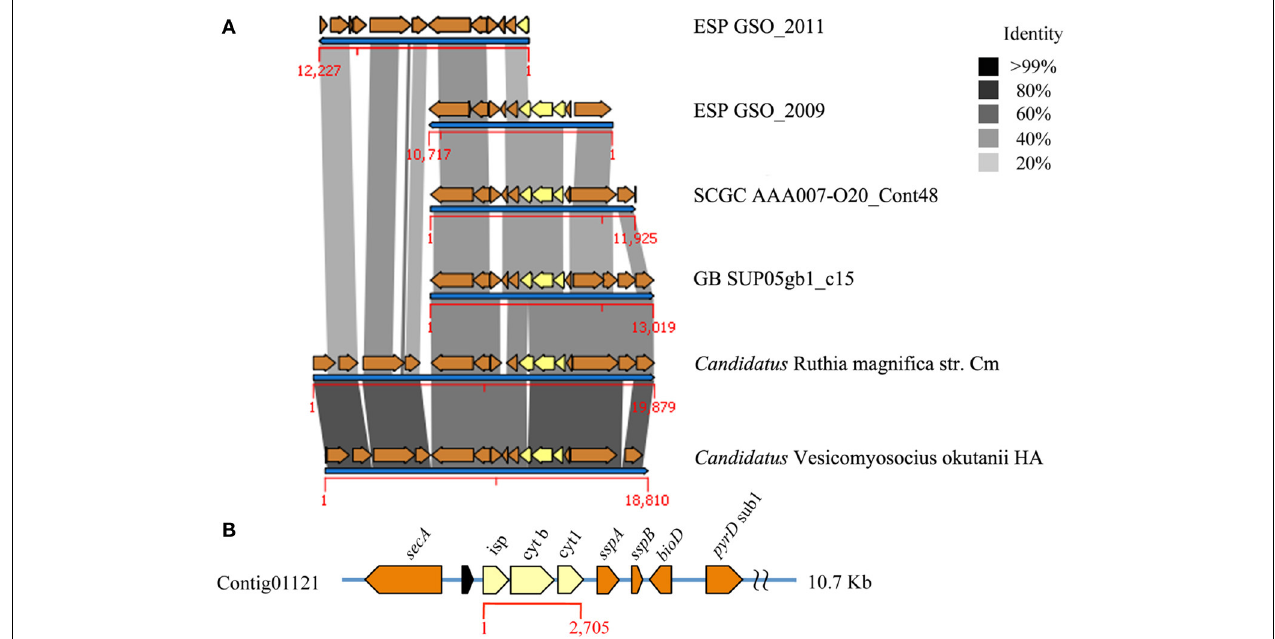
FIGURE 4 | Complex III of the oxidative phosphorylation pathway of the ESP-GSO lineage off the coast of Concepción. (A) Comparison of de novo contigs constructed with metagenomic sequences from 2009 and 2011 sampling. Cytochrome bc1 complex, previously undescribed for Saanich Inlet SUP05,isshowninyellowandthesyntenyofgeneticbackgroundwasanalyzed